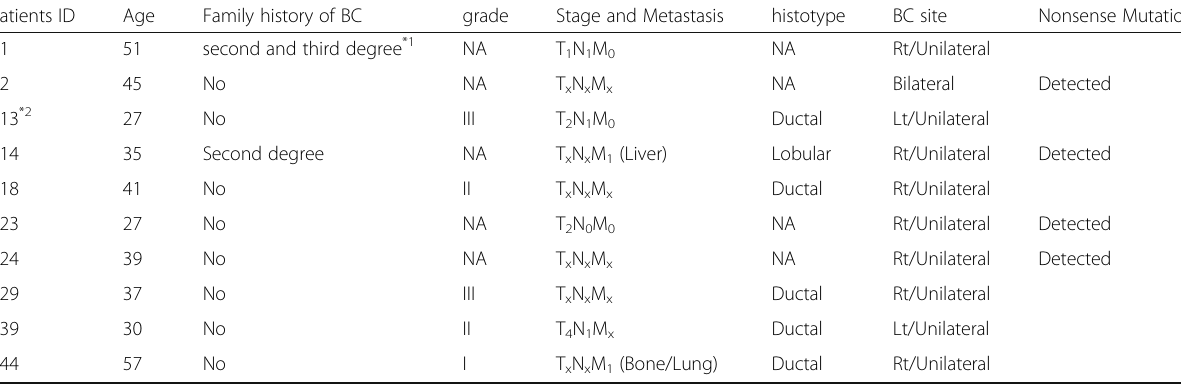
Table 3 The highly purified Breast Cancer Patients demographic, clinical, histological parameters with the nonsense mutation Patients